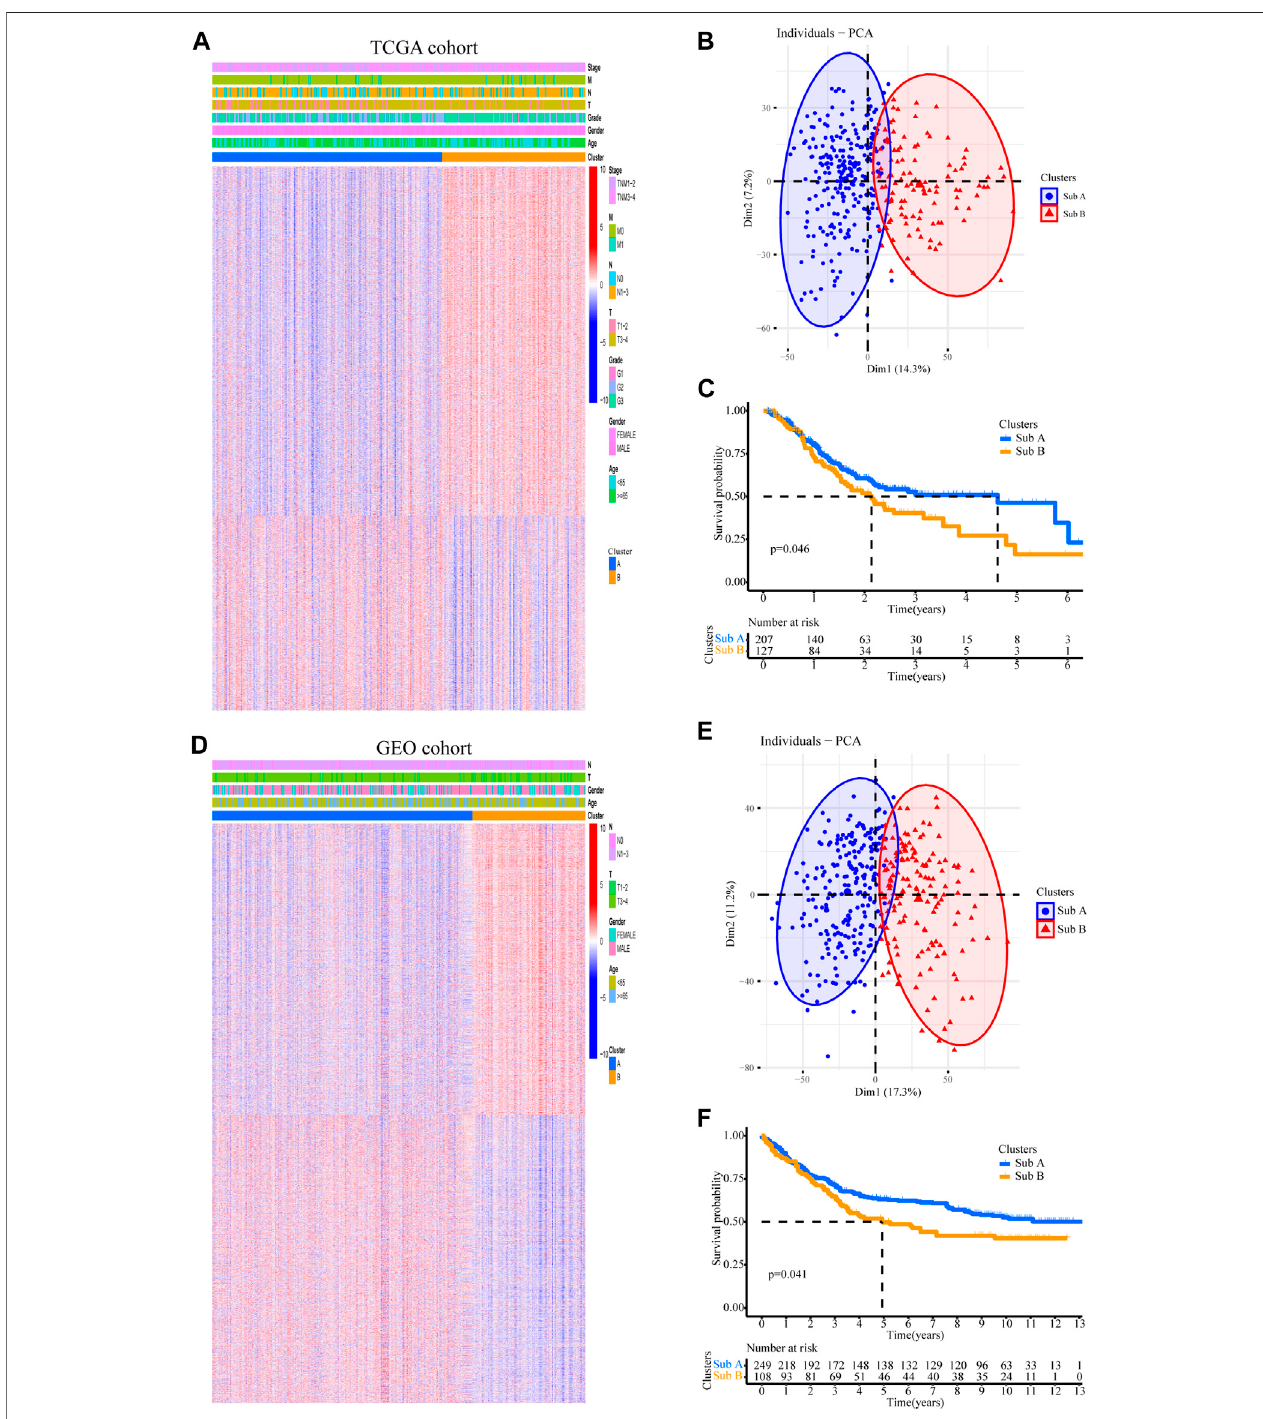
FIGURE1| Twosubtypeswithdifferentprognosisingastriccancerwereidenti fi edbyunsupervisedclusteranalysis. (A) Twosubtypesde fi nedby5,000geneswith highly variable expression are plotted as a heatmap. Genes with MAD value in the top 5,000. (B) Principal component analysis (PCA) revealed differences between the twosubtypesin TCGA cohort. (C) Kaplan-Meier survivalplot fortwosubtypes inTCGA cohort. (D) ThegenesequenceoftheTCGAtrainingset wasapplied totheGEO validation cohort. (E) PCA analysis revealed differences between the two subtypes in GEO validation cohort. (F) Kaplan-Meier survival plot for two subtypes in the GEO validation